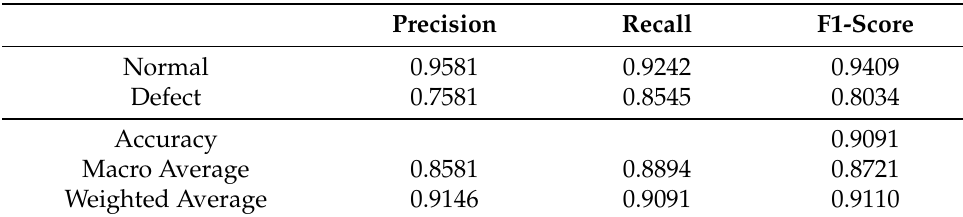
Table 5. Results of Proposed